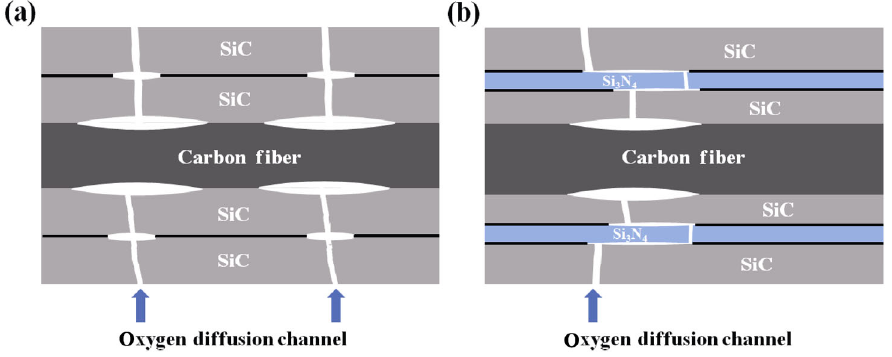
Fig. 8 Schematic diagram of the oxygen diffusion channels for C/SiC composites at 800 and 1000 ℃ : (a) without Si 3 N 4 matrix and (b) with multilayer SiC–Si 3 N 4